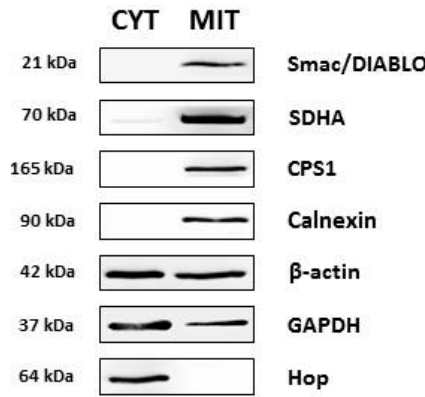
Figure 1. Comparison of the expression of selected proteins in cytosolic (CYT) and high-purity mitochondrial (MIT) fractions isolated from MCF7 cells using a QProteome Mitochondria Isolation Kit (see "Section 4"). The level of tested proteins was assessed using western blot analysis employing relevant antibodies (see "Section 4"). Smac/Diablo (Second mitochondria-derived activator of